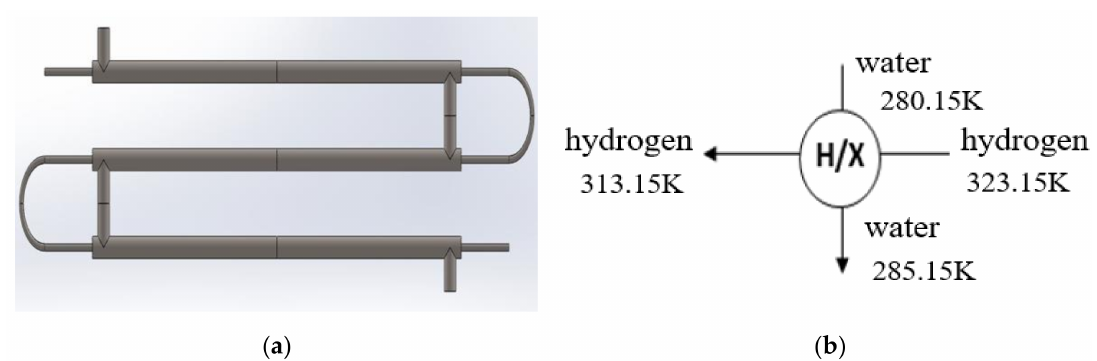
Figure 11. The heat exchanger. ( a ) Counter-flow heat exchanger; ( b ) working principle diagram of the heat